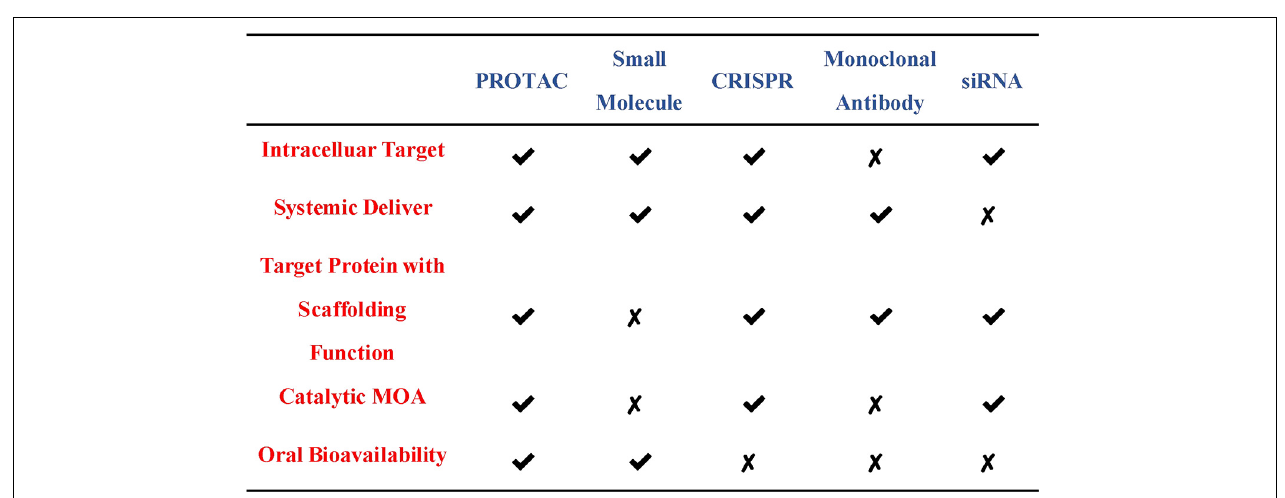
FIGURE 3 | Comparisons of PROTAC with other therapeutic